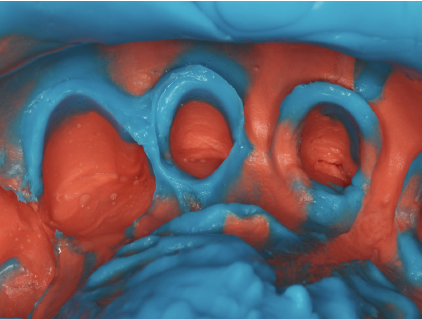
Figure 1: Initial clinical aspect, frontal view.